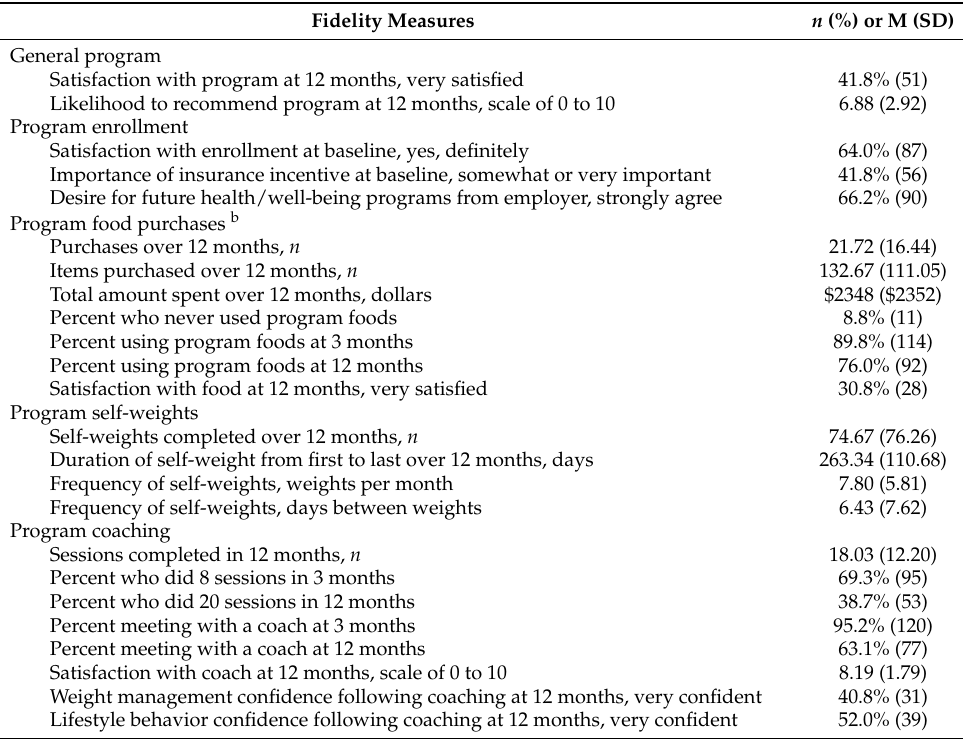
Table 4. Satisfaction and fidelity of program implementation from survey or administrative program data, n = 140 a